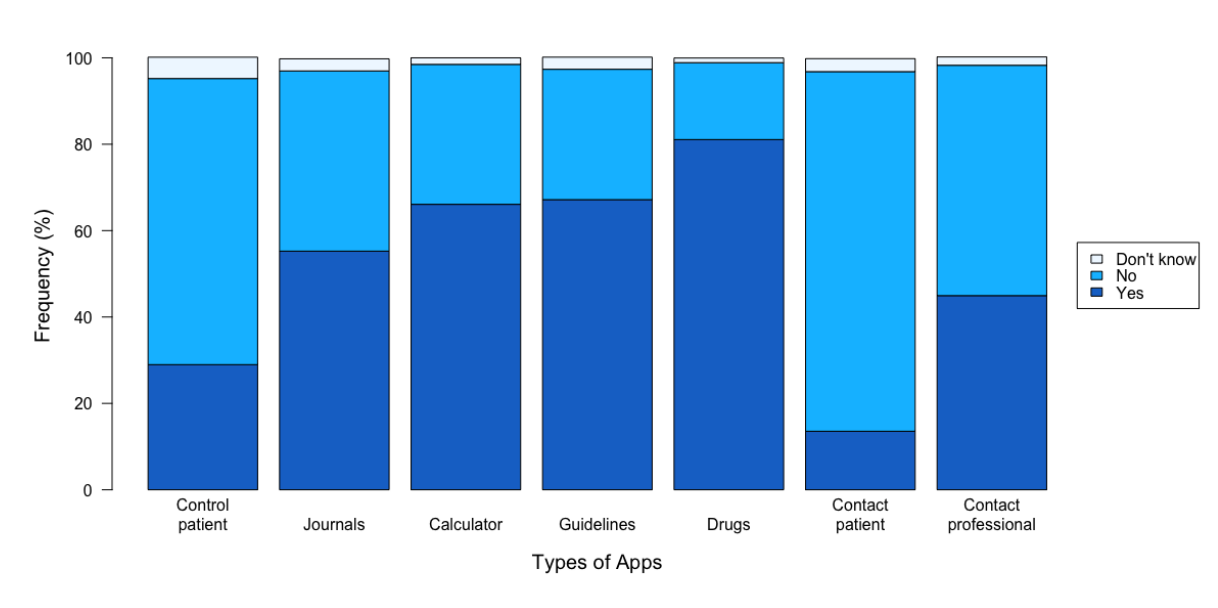
Figure 1. Most frequent types of apps used by